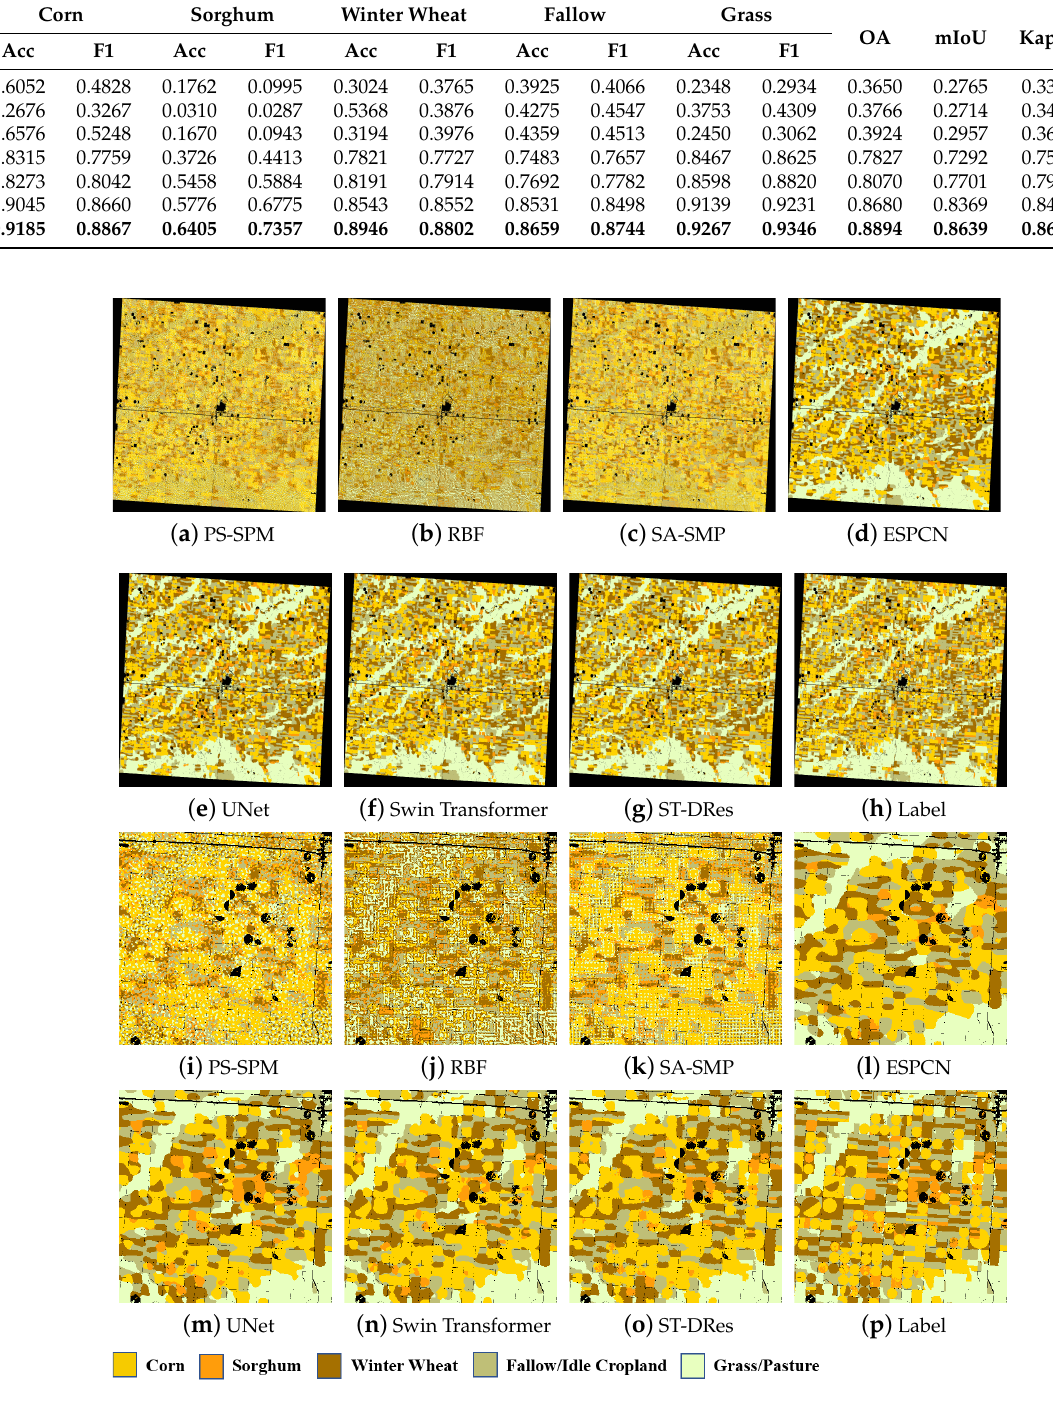
Figure 4. Predicted sub-pixel maps of different methods in Sherman Country in 2017 achieved by different methods. ( a – g ) show predictions for the entire Sherman County by different methods and ( h ) is the label map, ( i – o ) show SPM results for a small example area in Sherman County, and ( p ) is the corresponding label. Obviously, there are many misclassification pixels in the traditional SPM methods, and ESPCN and UNet networks produce excessively smooth maps. Moreover, the ST-DRes method achieves a good classification result, while Swin Transformer also shows a good result, inferior to ST-DRes only in some details and small classes, such as